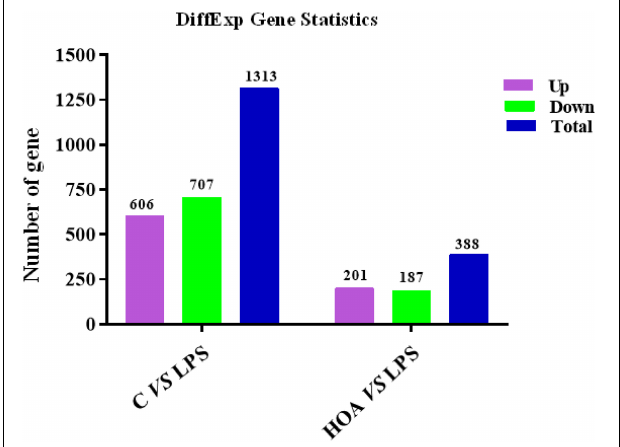
FIGURE 2 | Distribution pattern for differentially expressed